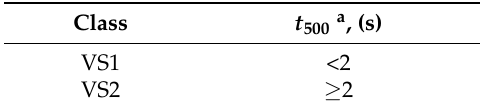
Table 6. Viscosity class in relation to time t 500 [47].